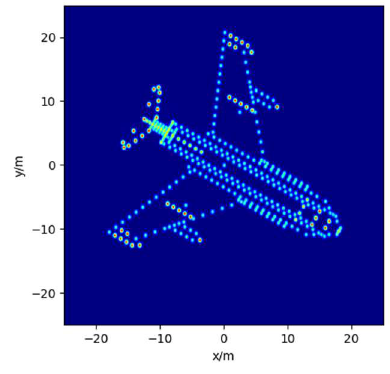
Figure 3. Ideal target image.